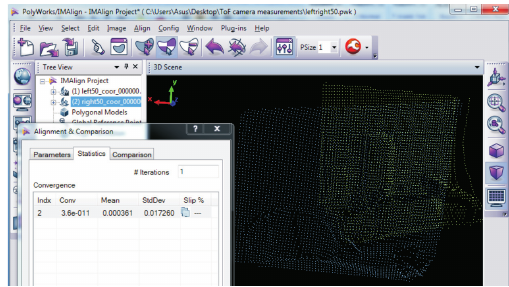
Fig. 3. The registered point clouds of RIM camera